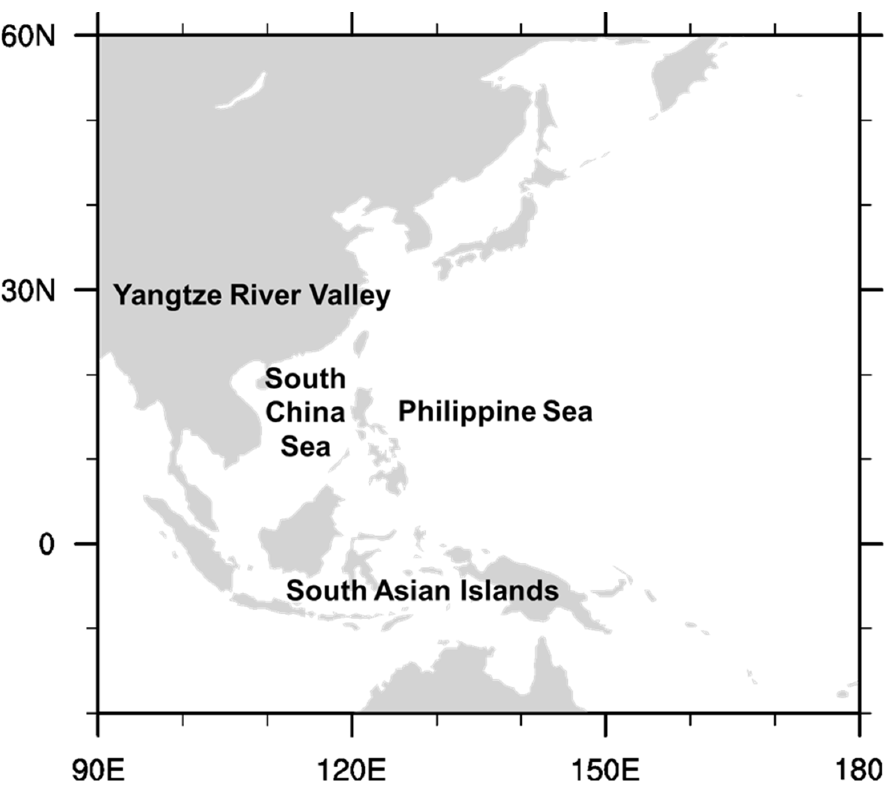
Figure 2. Geography mentioned in the study.